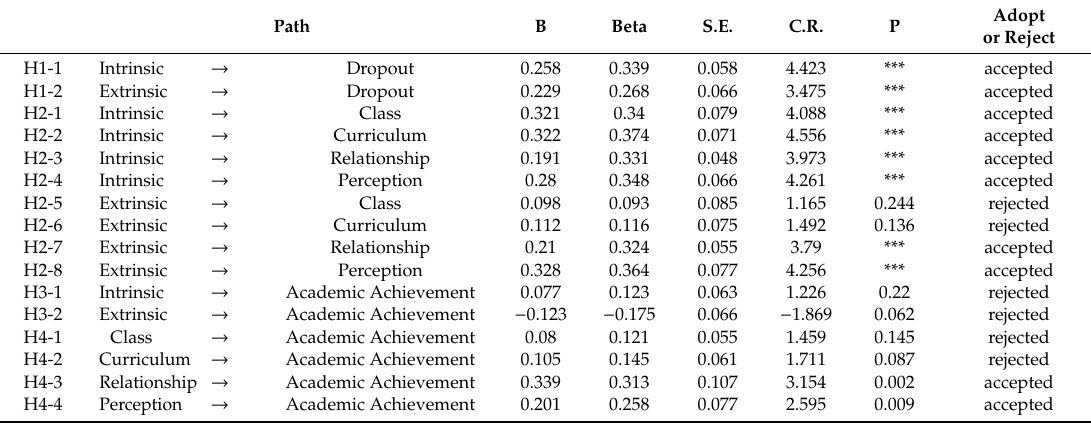
Table 5. Final Path Analysis Result.